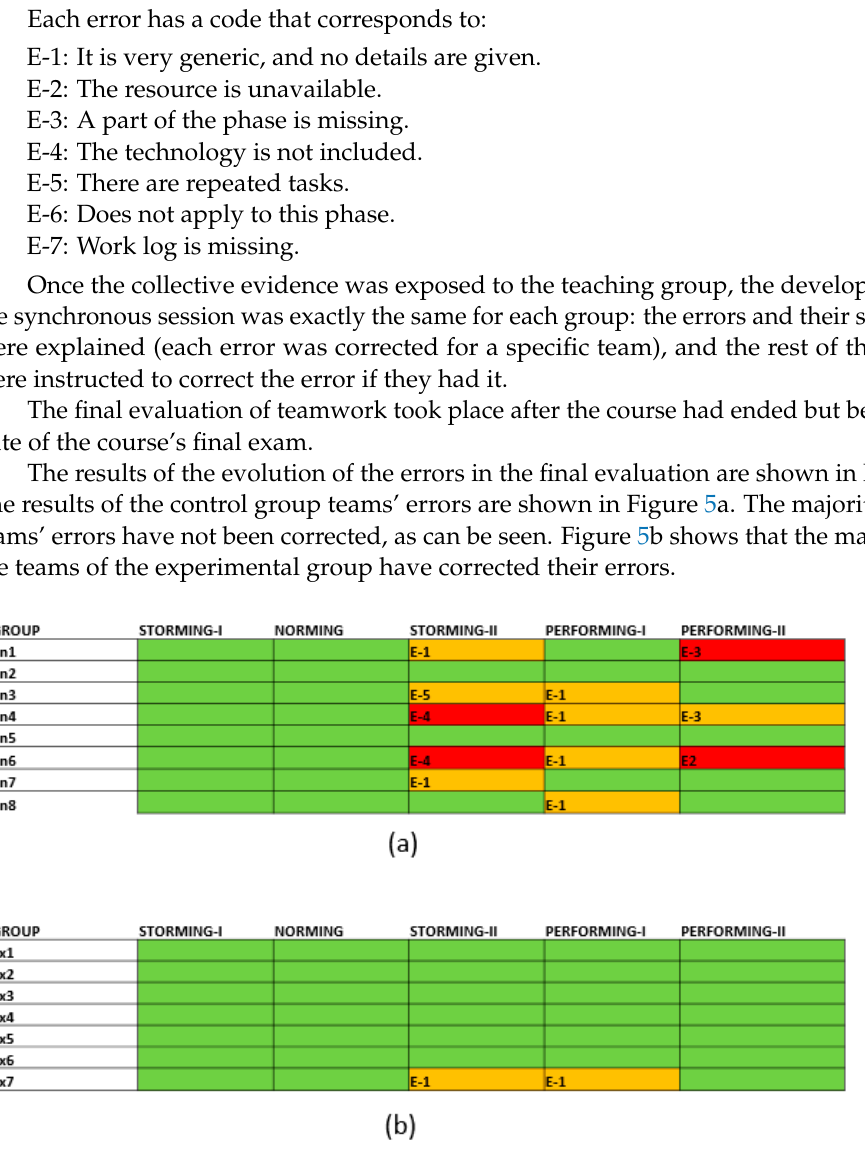
Figure 5. Traffic light for the control and experimental groups during the phases. ( a ) Control groups and ( b ) Experimental groups